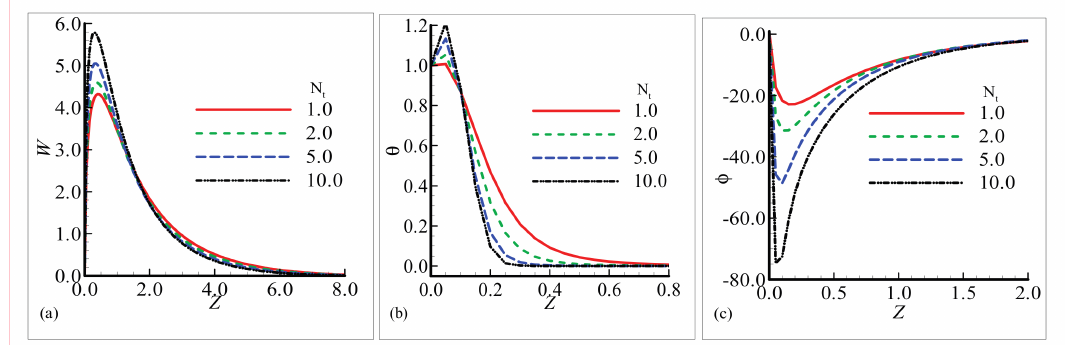
Figure 11. Physical e ff ects on quantities ( a ) u , ( b ) θ , and ( c ) ϕ versus Nt, when Sc = 0.8, Nb = 0.4, Pr = 0.71, M = 0.4, Q =